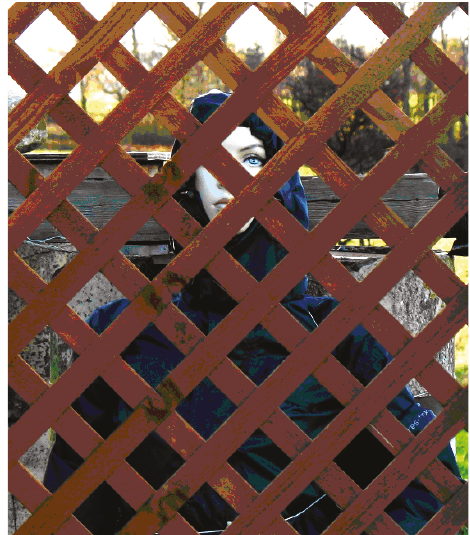
Figure 6: Close-up photograph of the upper half of the mannequin positioned at 1m behind a wooden fence. The scene was scanned at a stando ff distance of 325 m in